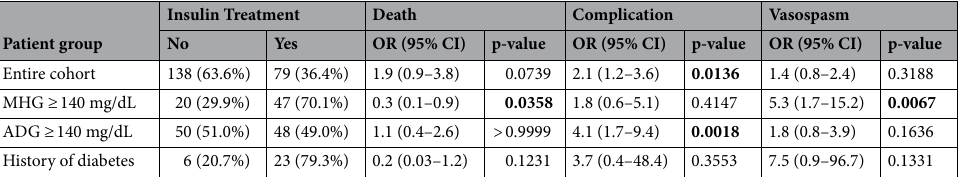
Table 5. The effect of insulin admission on rates of death, complications, and vasospasm. Bold values indicate statistical